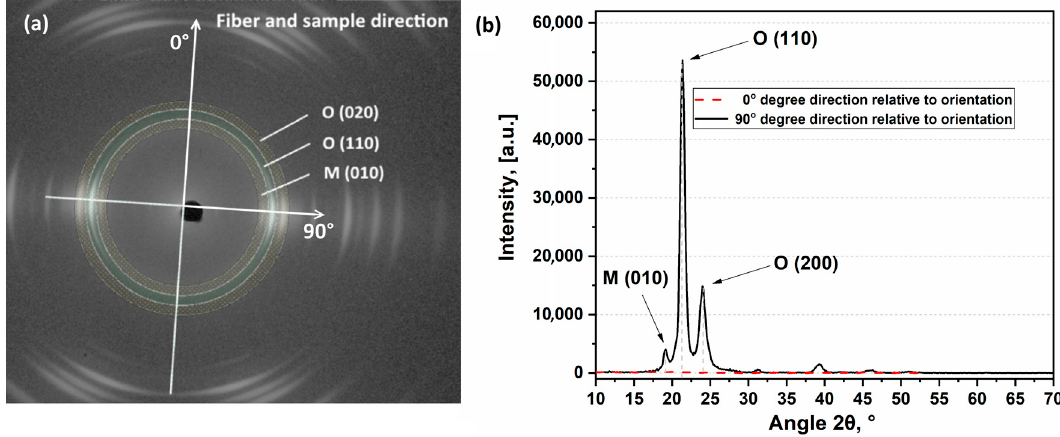
Figure 7. ( a ) 2D diffraction pattern and ( b ) 1D profile derived from 2D diffraction pattern—sample prepared at 145 °C and 25 MPa (Regime 2).